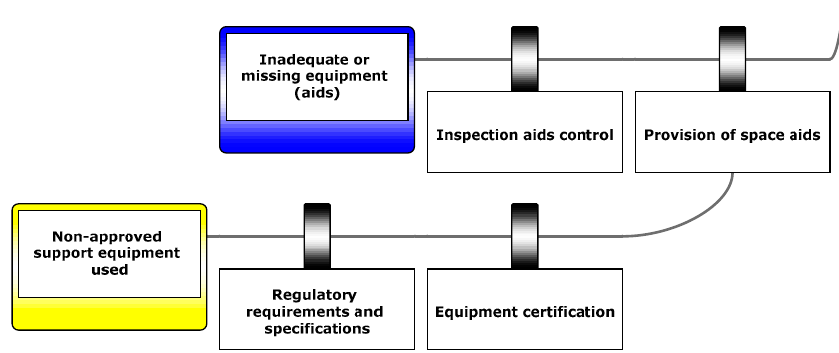
Figure A2f. “Borescope not available or set incomplete” threat paths.